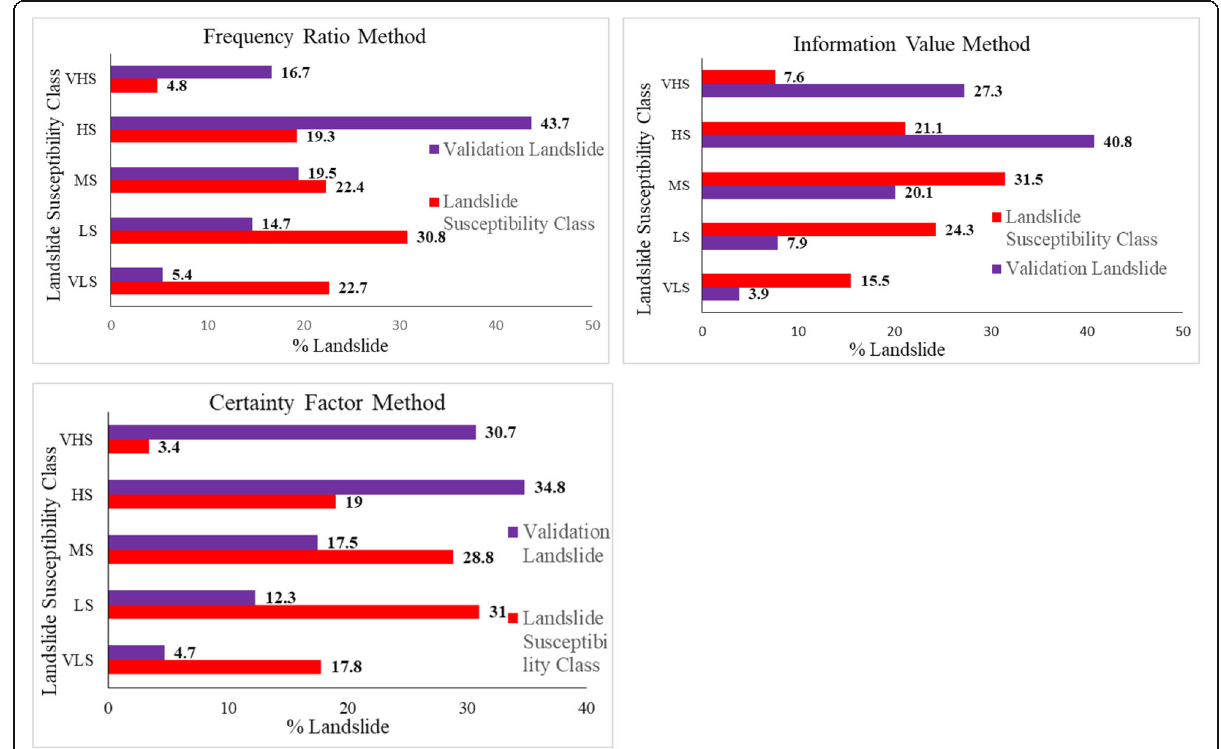
Fig. 10 Spatial distribution of predicted and observed